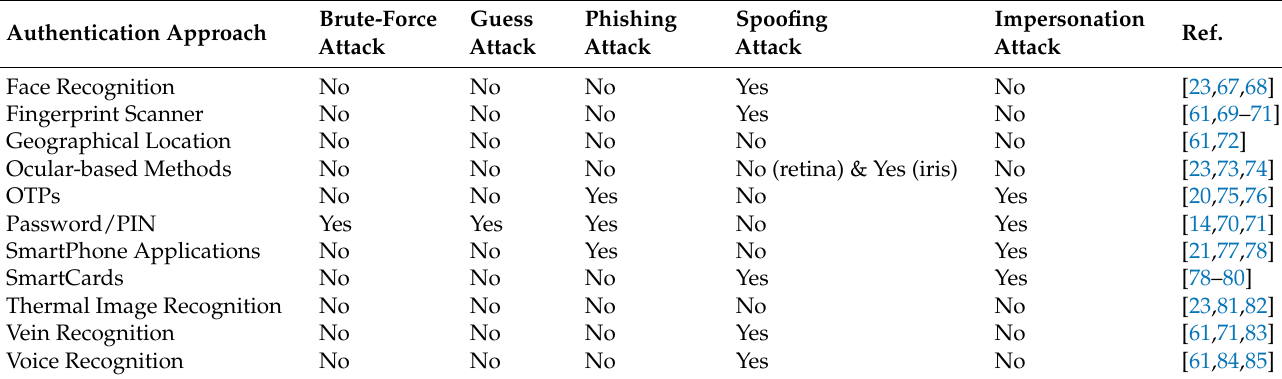
Table 3. Different authentication approaches and their vulnerability to various